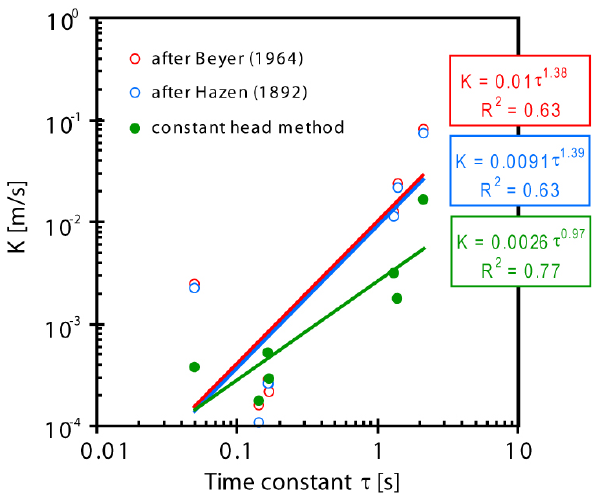
Fig. 8. Plot of the saturated hydraulic conductivity K versus the Cole-Cole relaxation time τ for uncompacted samples measured at an electrical conductivity of the the saturating pore water of ∼ 60µS/cm. K either was calculated from the grain-size distribu- tion measurements using the empirical, grain-size-based formulas of Beyer (1964) and Hazen (1892) or experimentally determined through constant-head-type